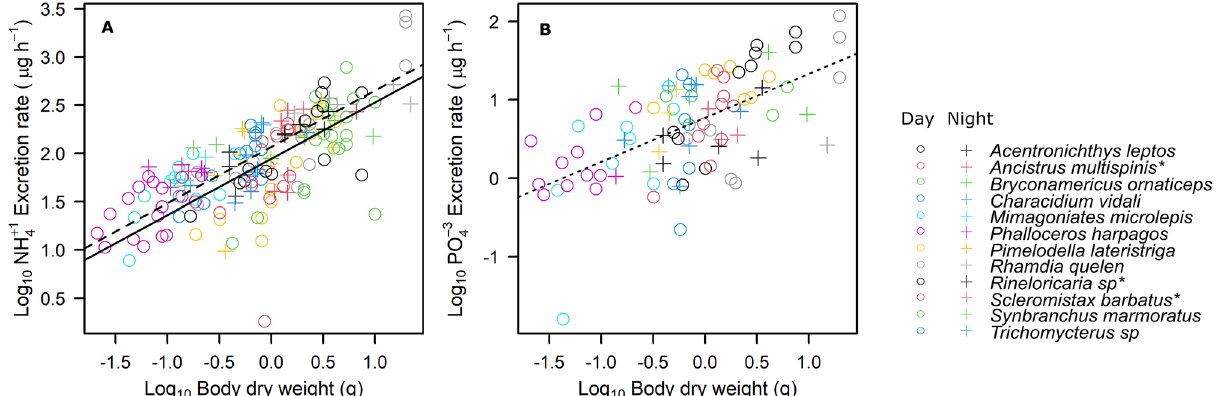
Figure 1. Fitted allometric relationships between fish body mass and excretion rates for N ( A ) and P ( B ) across 12 species in a Brazilian stream. In ( A ), the solid line represents the best fit for daytime excretion rates, and the dashed line represents nighttime excretion rates. There was no effect of time of day in the P excretion rate. Different colors represent different species as indicated in the legend.